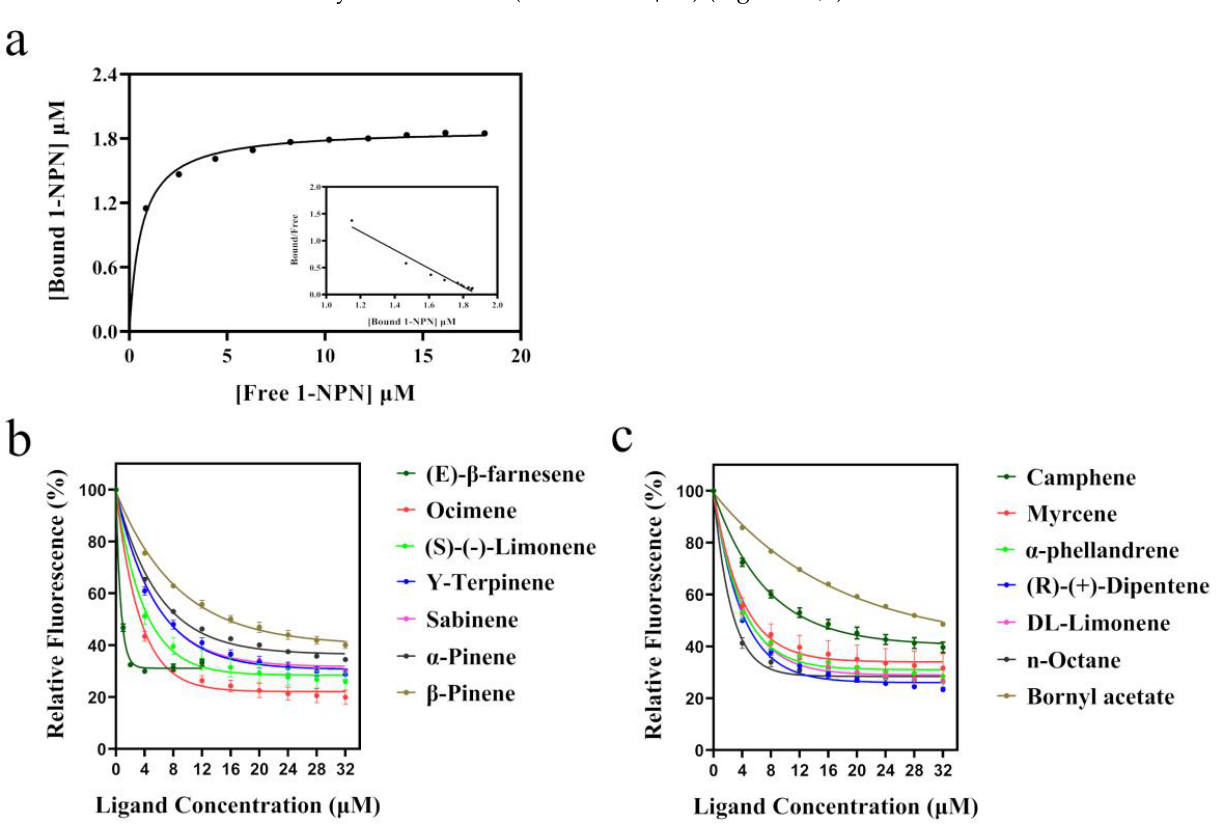
Figure 3. Ligand-binding experiment of OcomOBP7 . ( a ) The binding curve of OcomOBP7 and 1-NPN and Scathard equation. ( b , c ) The binding curve of OcomOBP7 and A. artemisiifolia volatiles.